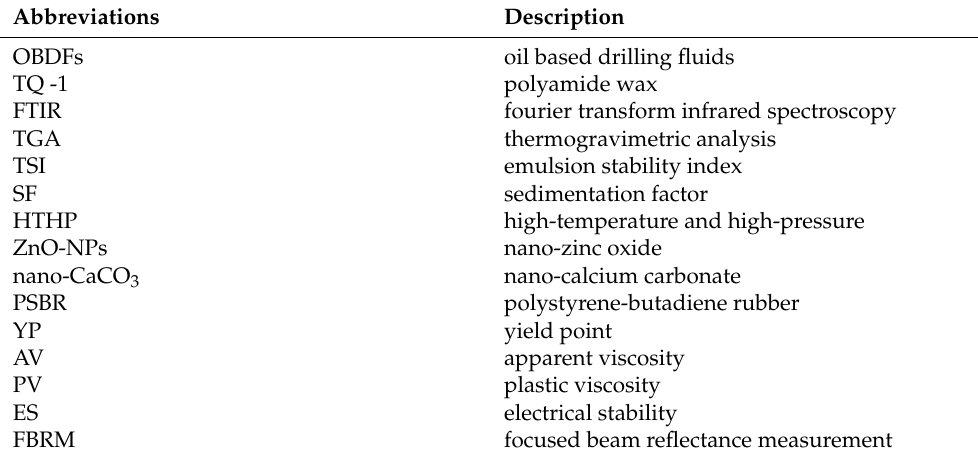
Table A1. List of